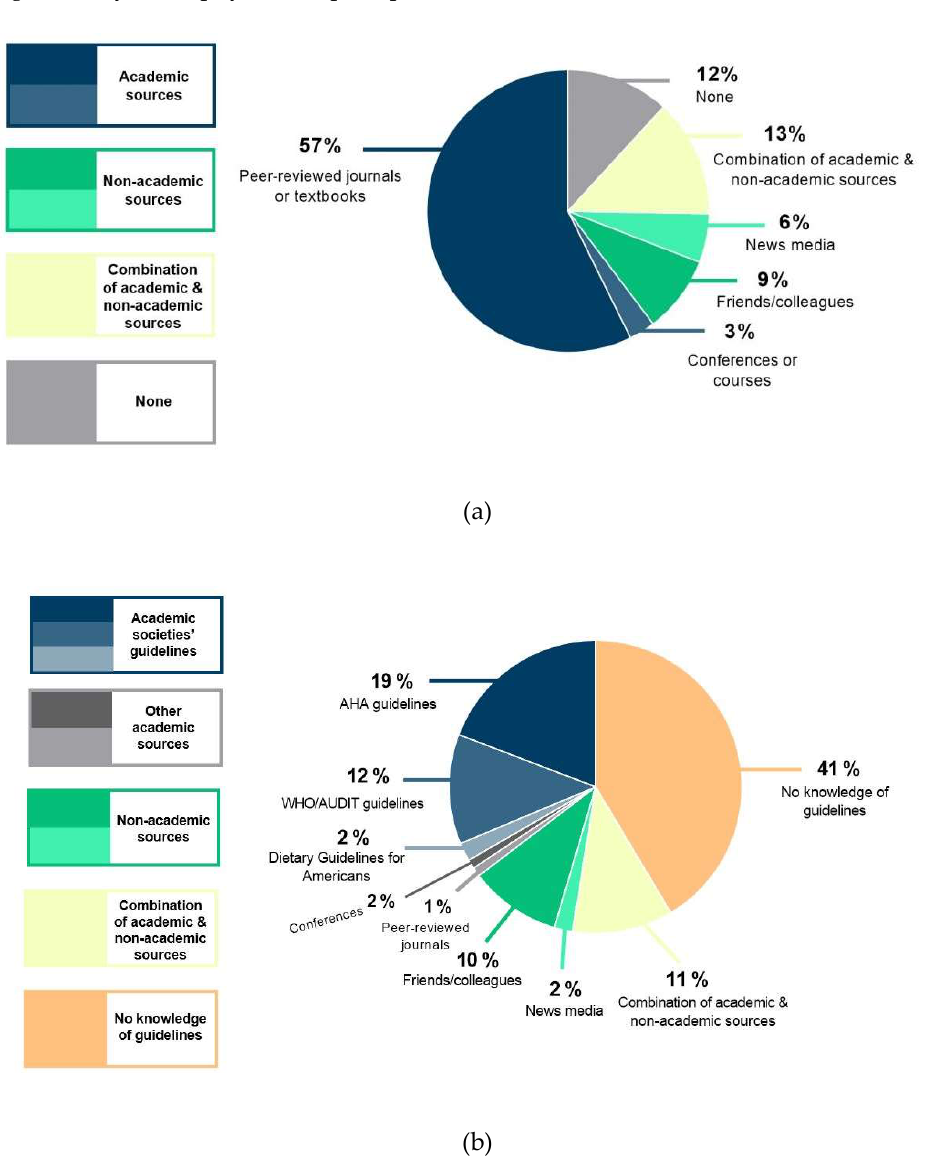
Figure 1. Physicians’ self-reported sources of knowledge on ( a ) alcohol and cardiovascular health, and ( b ) alcohol consumption guidelines.